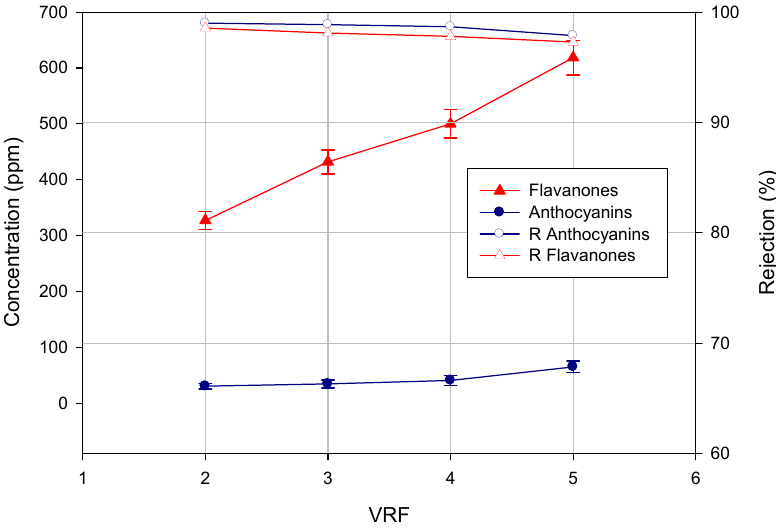
Figure 4. Concentration of flavanones and anthocyanins in the NF permeate as a function of